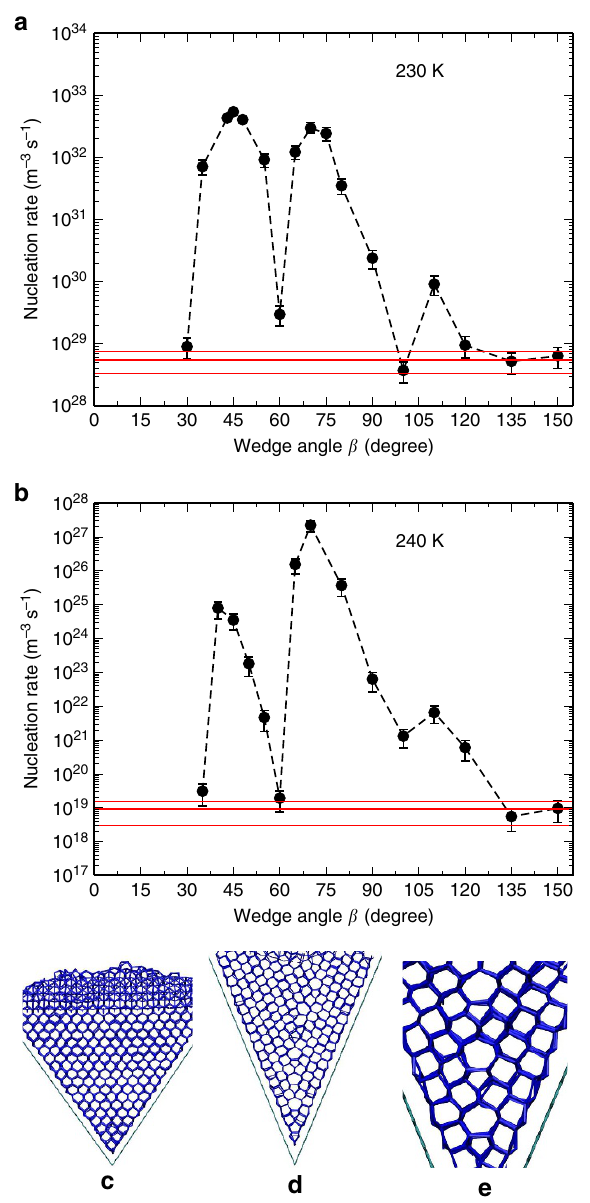
Figure 1 | Crystallization of mW water within atomically sharp wedge. Calculated rate constant of heterogeneous ice nucleation within an atomically sharp wedge as a function of wedge angle b at ( a ) 230K and ( b ) 240K. The red lines indicate the heterogeneous ice nucleation rates (with statistical uncertainty) computed on the flat graphene plane at the corresponding temperatures 22 . All the nucleation rates are calculated based on FFS method, except for those obtained at 230K for the 43 (cid:2) , 45 (cid:2) and 47 (cid:2) wedges, where spontaneous nucleation occurs frequently in direct MD simulations. In these cases, the nucleation rates are computed directly based on multiple direct MD shootings (see Methods for details). The statistical uncertainty of those nucleation rates calculated based on FFS is obtained by estimating both the variance in the binomial distribution of the number of configurations collected at each interface and the landscape variance in the starting configurations at each previous interface 42 . ( c , d ) Side view of the fully crystallized ice at 230K within the 70 (cid:2) and the 45 (cid:2) wedges, respectively. ( e ) Zoom in of d , to highlight the topologically defective structure. Water molecules and carbon atoms are represented by blue and green,